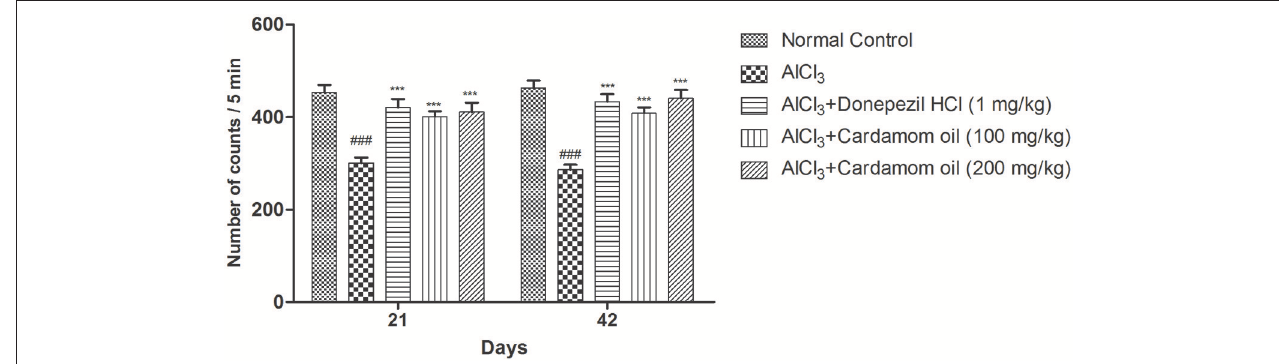
FIGURE 1 | Effect of Cardamom oil on locomotor activity of rats using actophotometer on AlCl 3 -induced neurotoxicity. Data are expressed as mean ± SEM ( n = 6), ### p < 0.001 when compared with normal control, *** P < 0.001 when compared with disease control group. AlCl 3 , Aluminum chloride; SEM, Standard Error of Mean.